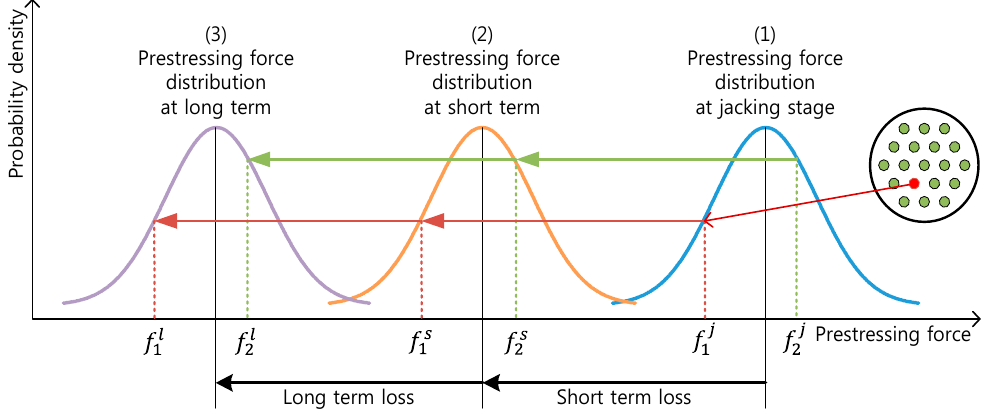
Figure 15. Concept of the estimation of the prestress force distribution.